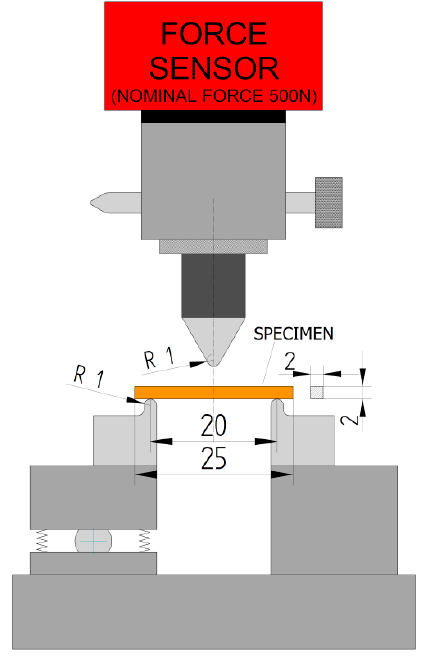
Figure 2. Supportsystem, Figure 2. Support system, pin and specimen in the three-point bending test (values are given in millimeters).